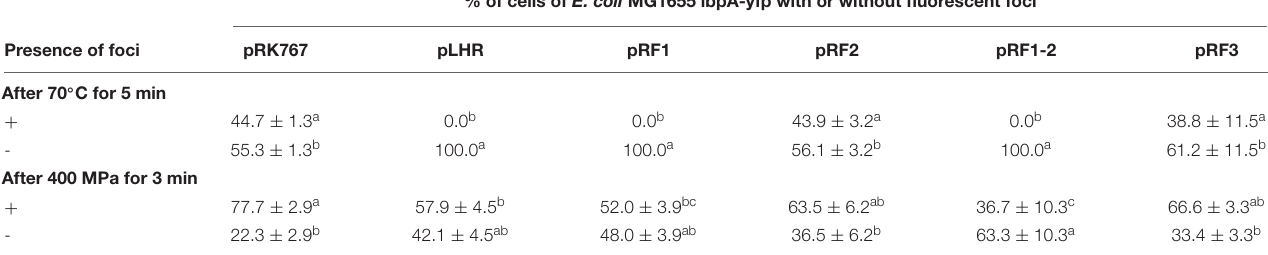
TABLE 5 | Differential enumeration of cells containing none, or one or more foci representing protein aggregates in E. coli MG1655 ibpA-yfp (pRK767), E. coli MG1655 ibpA-yfp (pLHR), E. coli MG1655 ibpA-yfp (pRF1), E. coli MG1655 ibpA-yfp (pRF2), E. coli MG1655 ibpA-yfp (pRF1-2), and E. coli MG1655 ibpA-yfp (pRF3). % of cells of E. coli MG1655 ibpA-yfp with or without fluorescent foci